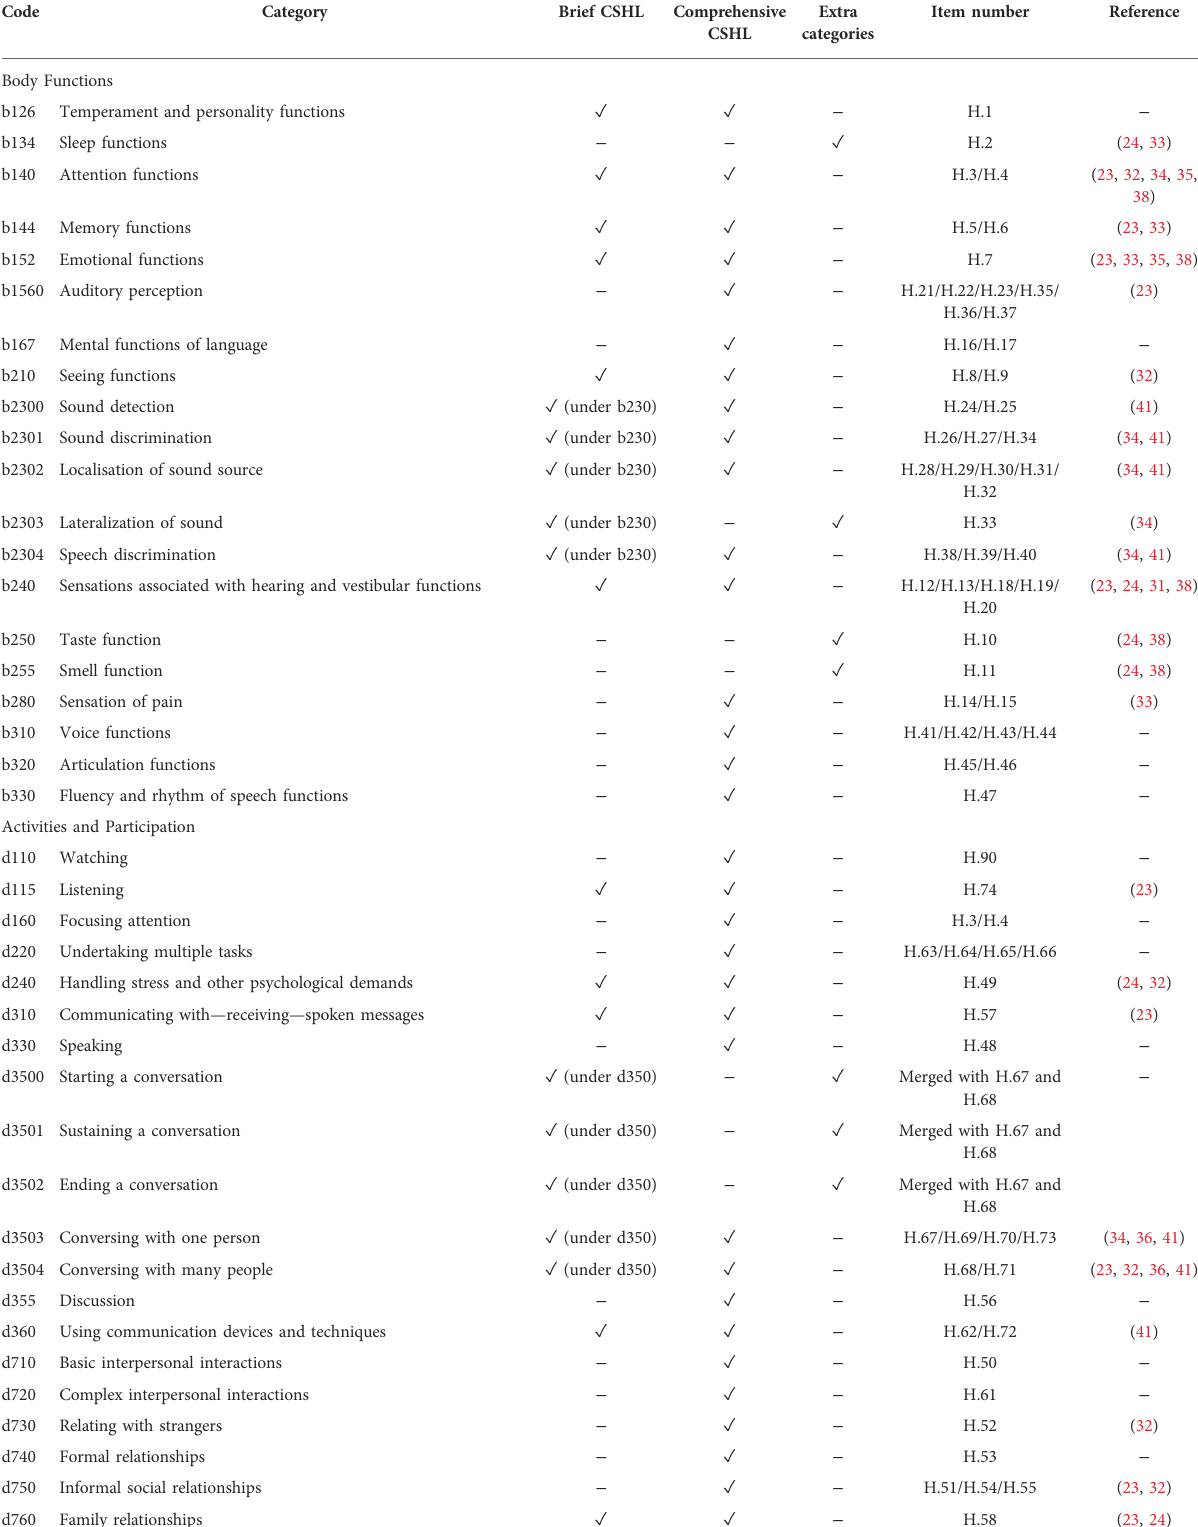
TABLE 3 The International Classi fi cation of Functioning, Disability and Health (ICF) categories of the Core Set for Hearing Loss (CSHL) covered in the tool along with the item number and the references used for the item